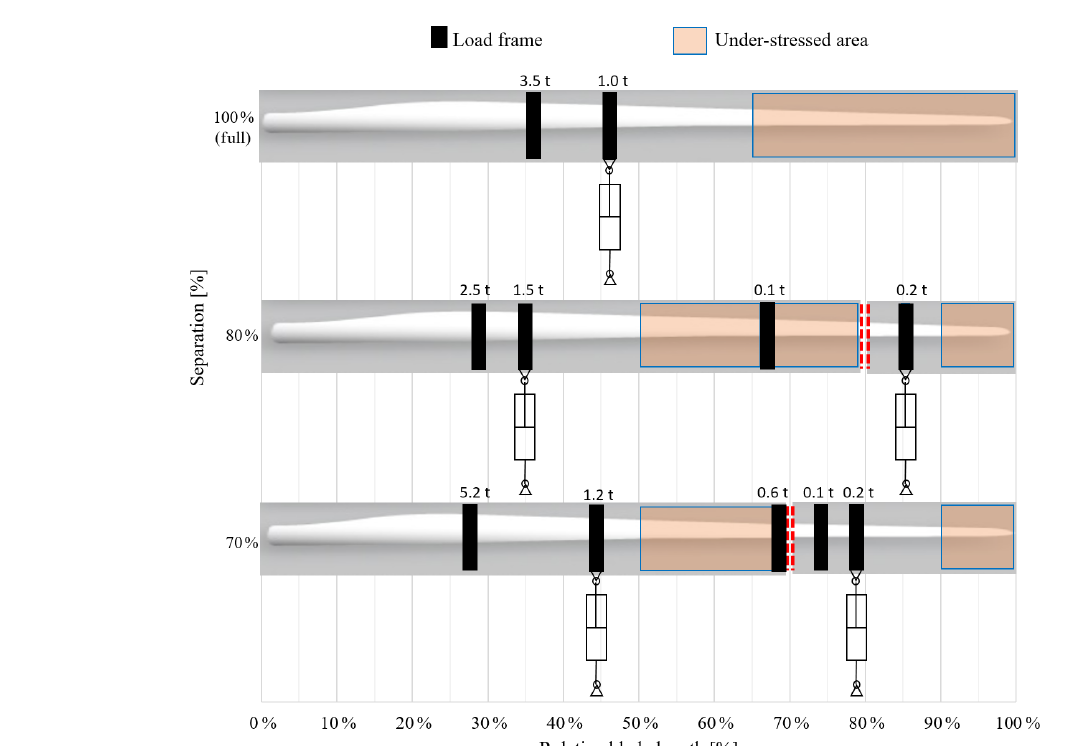
Figure 14. Comparison of test setups and under-stressed areas (60m blade, lead-lag fatigue